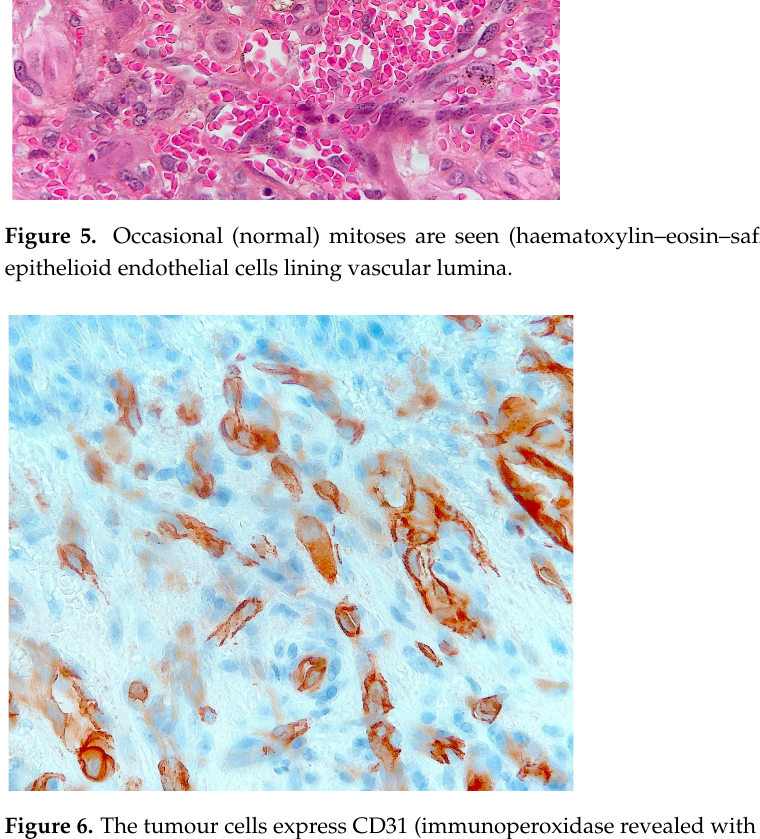
Figure 6. The tumour cells express CD31 (immunoperoxidase revealed with diaminobenzidine).